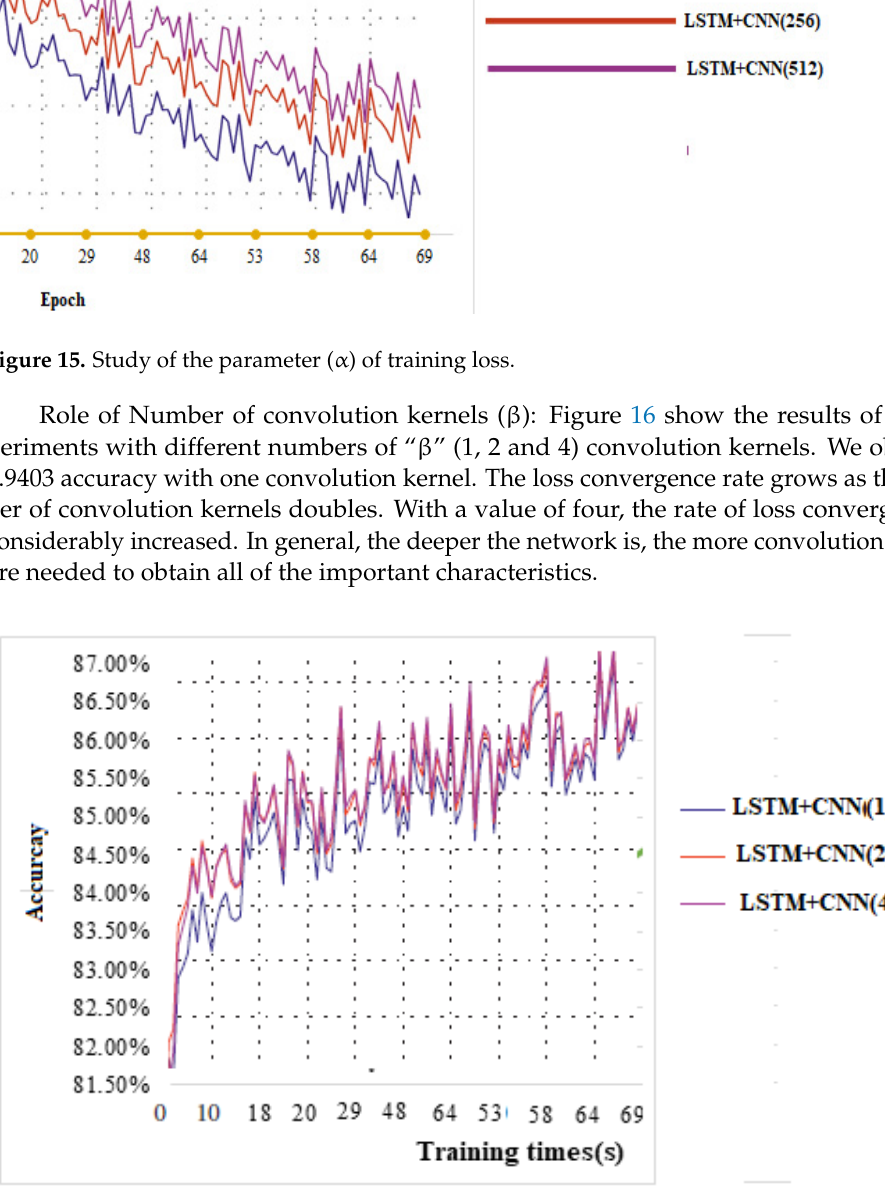
Figure 17. Study of the parameter ( γ ) of validation loss. 4.1.5. RO2: To Compare the Efficiency of the Suggested LSTM+CNN Approach to That of Machine Learning and Deep Learning Techniques To address the second research objective, “To compare the efficiency of the suggested LSTM+CNN approach to that of machine learning and deep learning techniques”, the results of the LSTM-CNN model for forecasting court judgments were contrasted with those of various traditional machine learning approaches as well as deep learning methods. Suggested model (LSTM+CNN) versus machine learning: The suggested approach (LSTM+CNN) was tested against standard machine learning models in order to evaluate